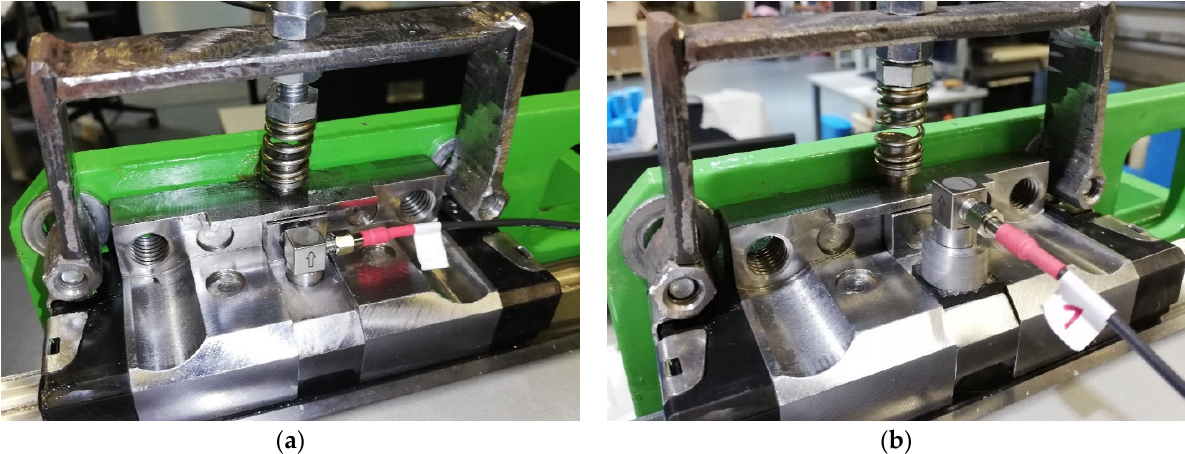
Figure 5. The placing of acceleration sensor: ( a ) with magnet; and ( b ) with rubber spring and additional weight.